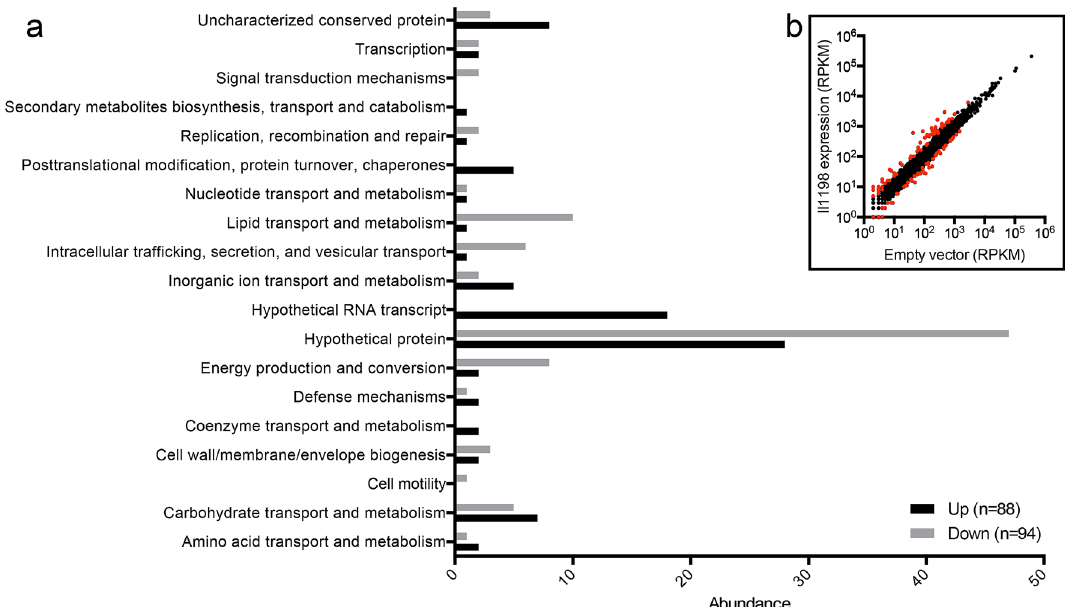
Figure 3. Hypothetical proteins are disproportionately controlled by BP1026B_II1198. ( a ) Genes with a q-value < 0.01 and a log 2 FC ≤ -1 or ≥ 1 were analyzed by COG functional predictions. There are 88 genes that are up-regulated and 94 genes that are down-regulated by BP1026B_II1198. Hypothetical proteins, hypothetical RNA transcripts and uncharacterized proteins represent 79.8% of the genes controlled by BP1026B_II1198. Of these unknown proteins 68% are up-regulated and 32% are down-regulated. ( b ) Scatter plot showing distribution of all genes present in RNA-seq analysis. Genes with a q-value < 0.01 and a log 2 FC ≤ -1 or ≥ 1 are highlighted in